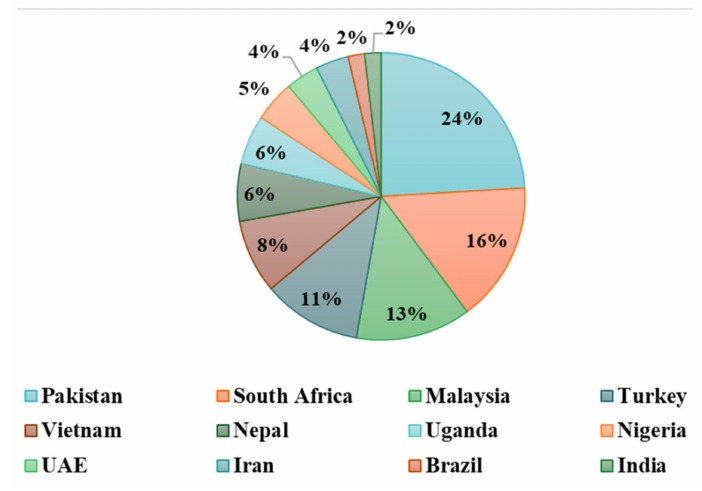
Figure 2. Geographic distribution of respondents.